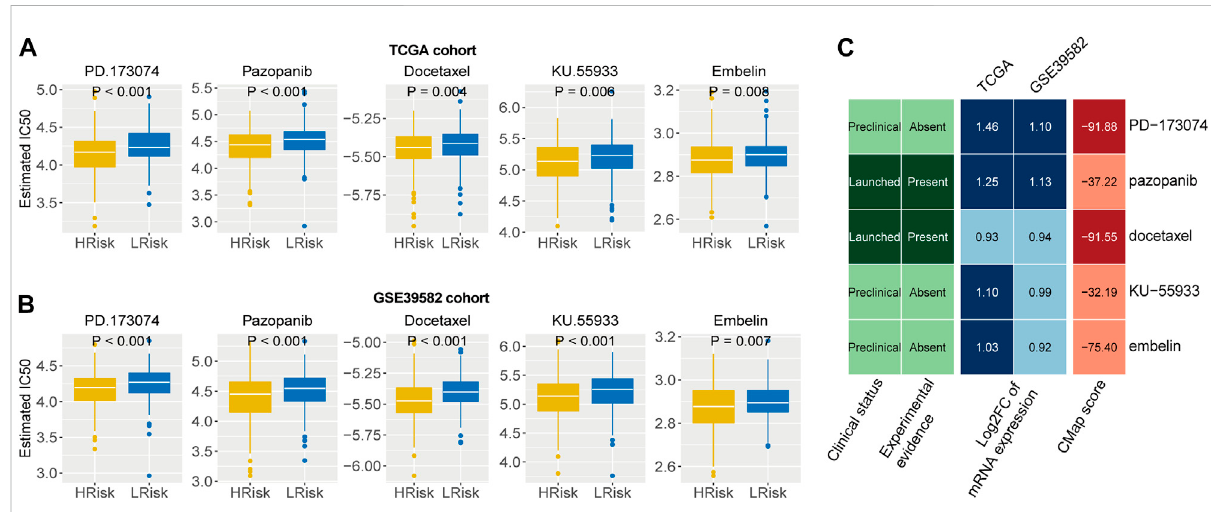
FIGURE 7 Identi fi cation of potential therapeutic agents for high-risk patients (A,B) Five agents with higher drug sensitivity in the high-risk group. The p values were calculated by the Wilcoxon test. (C) CMap analysis of fi ve drugs with potential therapeutic agents for high risk